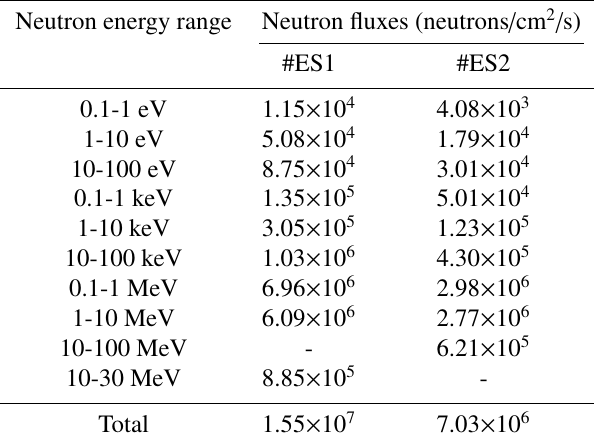
Table 1: Comparison of neutron fluxes of Back-n #ES1 and #ES2 in di ff erent neutron energy ranges at 100